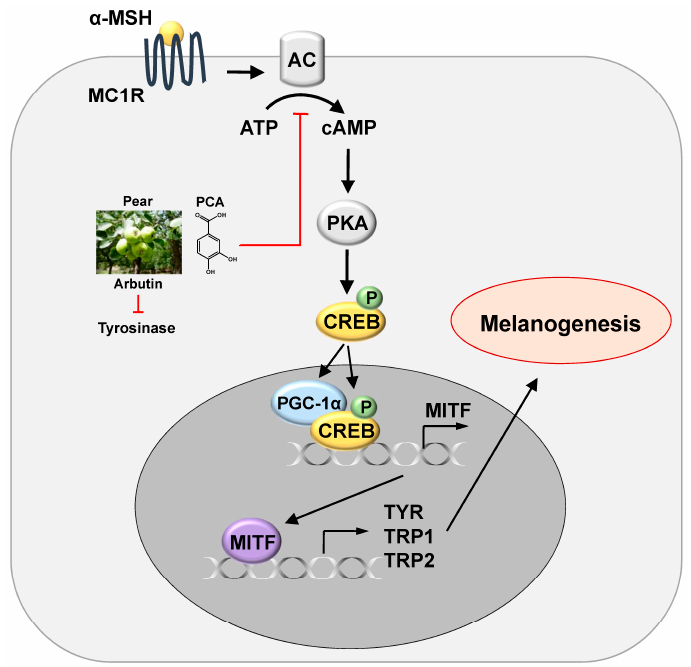
F igure 6 Figure 6. A proposed mechanism for inhibitory effect of PE and its components (PCA and arbutin) on melanogenesis. Arrows indicate positive regulation while T-bars denote inhibitory